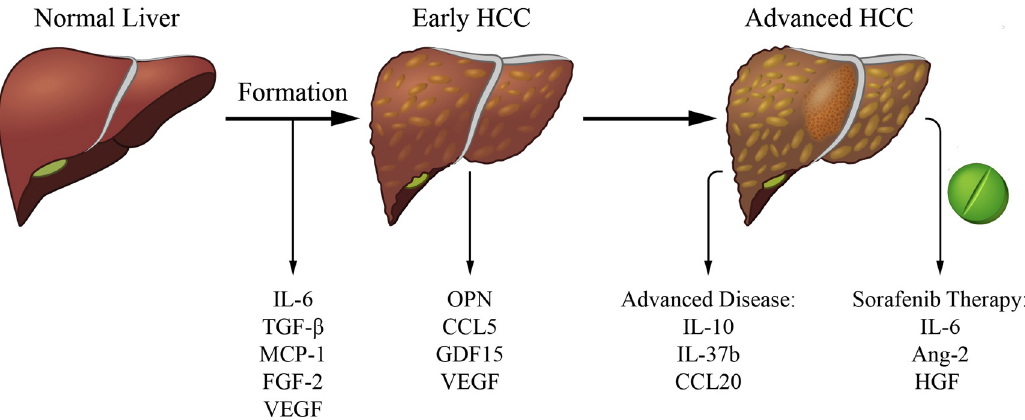
Figure 1. Cytokines of clinical relevance in the different stages of liver cancer. List of selected cytokines involved in tumor formation, relevant in early HCC detection and with prognosis potential in advanced disease and response to systemic (sorafenib) therapy.